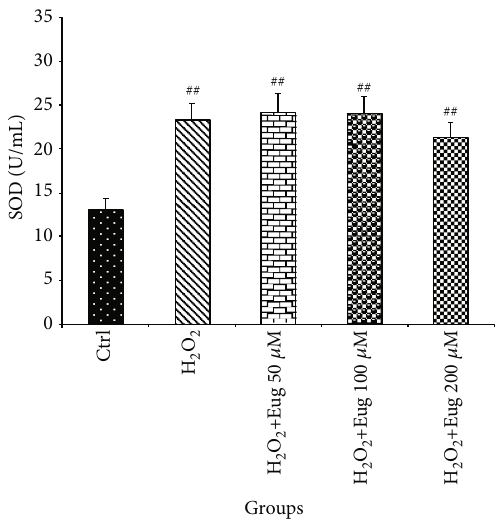
Figure 3: E ff ects of H O and eugenol on the SOD level of islets of 2 2 Langerhans. Data are expressed as the mean ± SE , n = 6 (7 islets in each sample). ## P < 0 : 01 signi fi cantly di ff erent with the control group. Eug: eugenol.